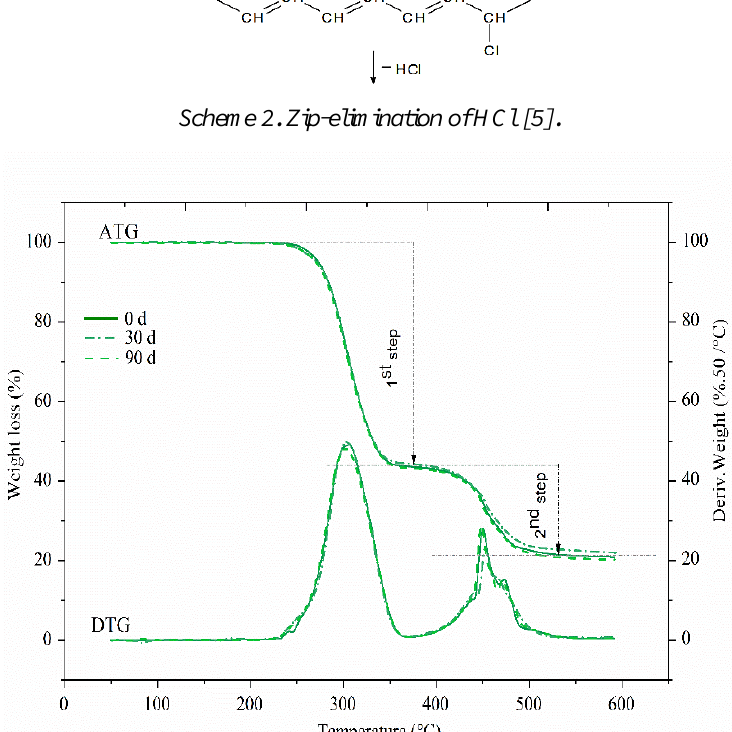
Fig. 6. Thermogravimetric and differential thermogravimetric (TG, DTG) curves of (u- PVC) aged at 80 °C for three aging stages (0, 30 and 90